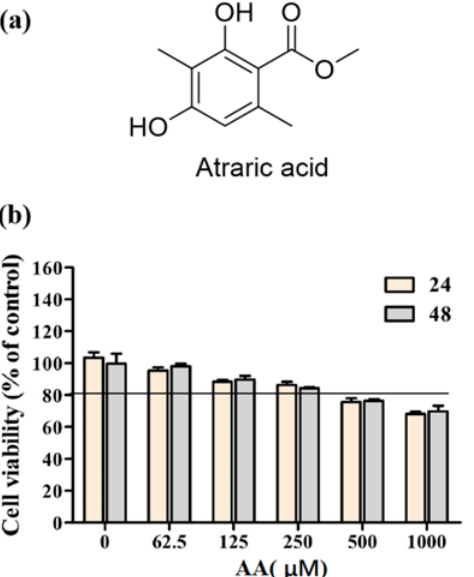
Figure 1. Chemical structure of atraric acid ( a ). The viability of different concentrations ( b